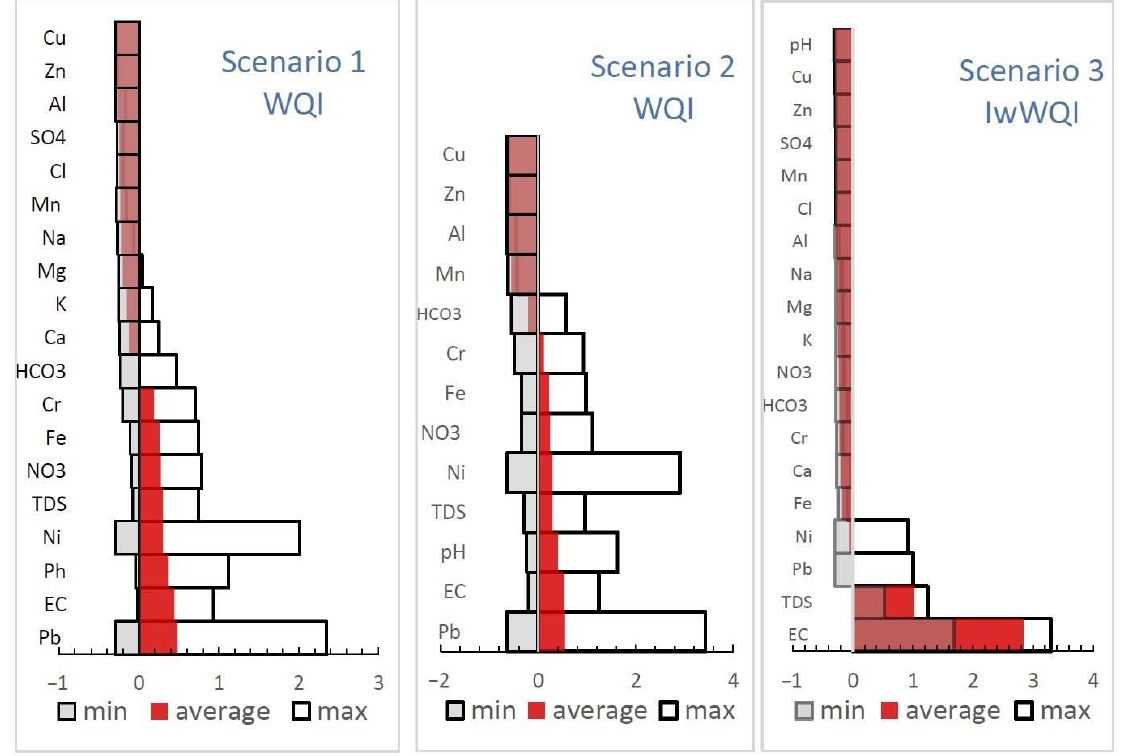
Figure 6. Sensitivity analysis (S i ) of removing each parameter on the score of WQI (Scenario 1 and 2) and IwWQI (Scenario 3) (values were ordered in descending